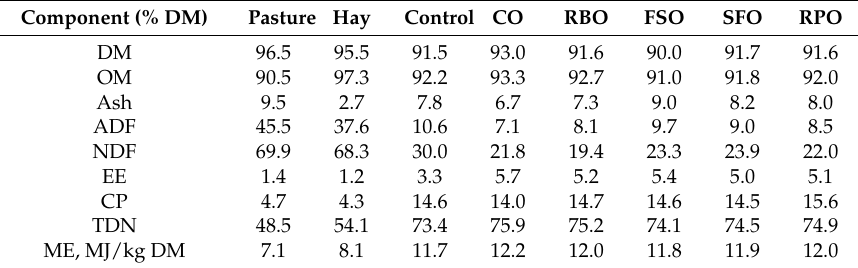
Table 2. Nutrient compositions a of basal and experimental diets b